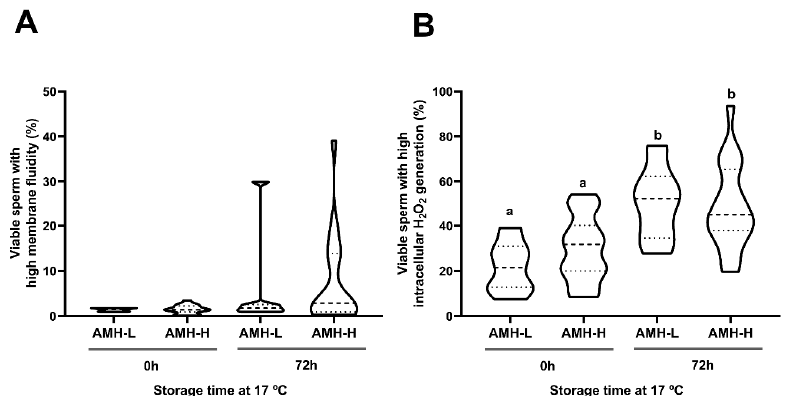
Figure 3. Association between the concentration of the anti-Müllerian hormone in boar seminal plasma (SP-AMH) and sperm quality parameters of semen samples stored at 17 ◦ C up to 72 h. Violin plots represent percentages and distribution of ( A ) total motile sperm, ( B ) progressive motile sperm, and ( C ) viable sperm with intact acrosome membrane of semen samples (n = 26) assessed at 0 and 72 h after liquid-storage. The semen samples were hierarchically grouped ( p < 0.001) as presenting low- (AMH-L; ranging from 479.92 to 701.84 ng / mL, n = 7) or high- (AMH-H; ranging from 770.53 to 1096.72 ng / mL, n = 19) SP-AMH concentration. Dashed line represents the median and dotted lines the 25 and 75% quartiles. No significant di ff erences were found between the SP-AMH groups in any sperm quality parameter.